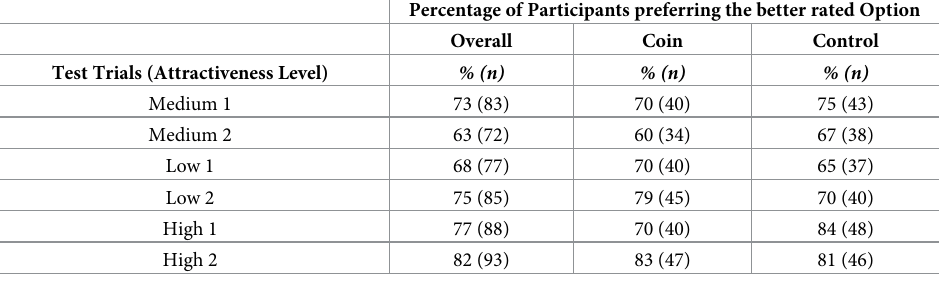
Table 4. Percentage of preference alignment in Study